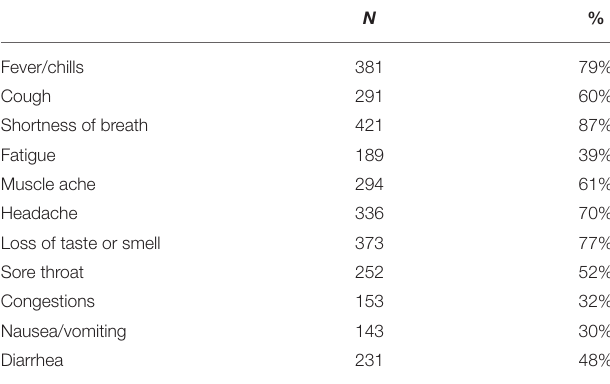
TABLE 2 | How does COVID-19 (Coronavirus Disease-2019) spread?